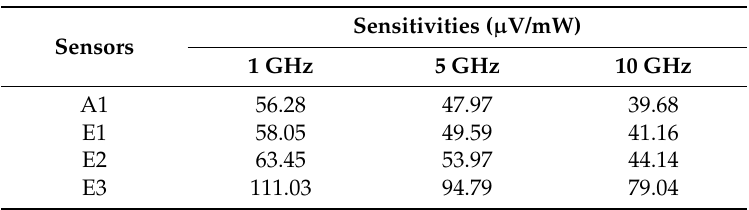
Table 1. Comparison of average sensitivities of the four n + GaAs/AuGeNi-Au thermocouple-type RF power sensors in GaAs